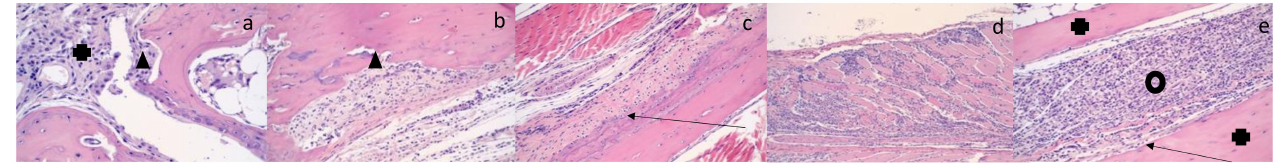
Figure 5. Histologic Evidence of Inflammation by 7 days post-infection (DPI) ( a – e ). ( a ) The section shows a lympho- histiocytic synovitis (denoted by a cross) with articular cartilage scalloping and articular cartilage erosion (denoted by a triangle) with extension to cortical bone erosion. The lympho-histiocytic inflammatory response overlies the articular cartilage and cortical bone. There are no neutrophils, no vasculitis and no fibrinoid necrosis. ( b ) The section shows an active periostitis with cortical bone erosion (denoted with a triangle) consisting of inflammatory mononuclear cells and osteoclastic giant cells. There is no evidence of neutrophilic infiltration. Adjacent to the cortical bone erosion is an active mononuclear periostitis. ( c ) Section shows cortical bone with active periostitis, cortical bone erosions and reparative new bone formation (thin arrow). ( d ) Sections demonstrate a mononuclear lympho-histiocytic active myositis with myofiber degeneration and minimal regenerative activity; there is no evidence of healing or fibrosis. ( e ) The section shows interosseous inflammation (denoted with a circle) of soft tissue that is predominantly mononuclear without evidence of granuloma or suppuration. Bone is denoted with a cross. A periostitis is present on cortical bone surface (thin arrow).